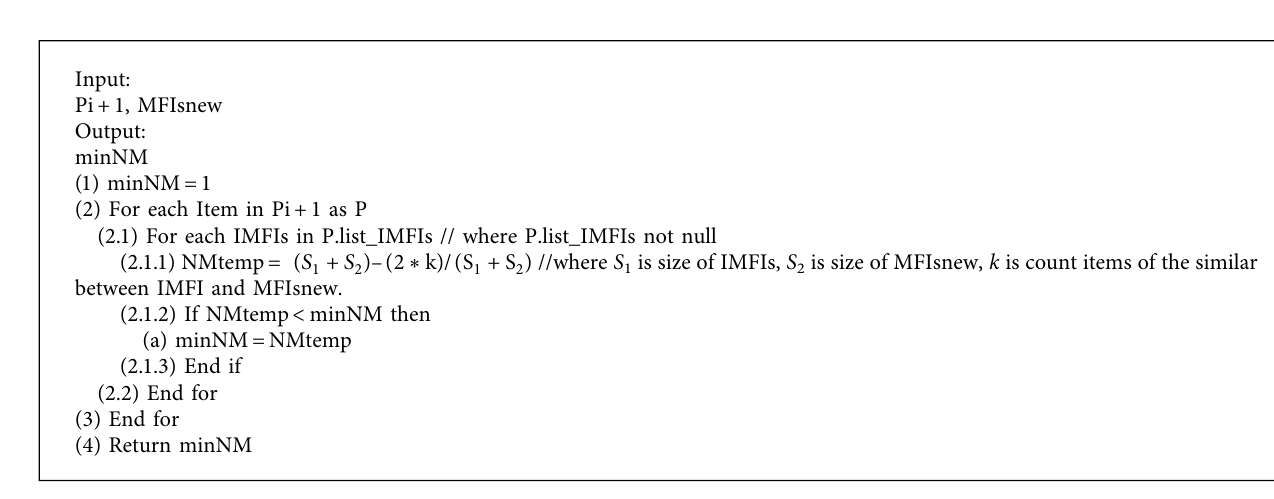
A LGORITHM 4: Interesting measure algorithm.